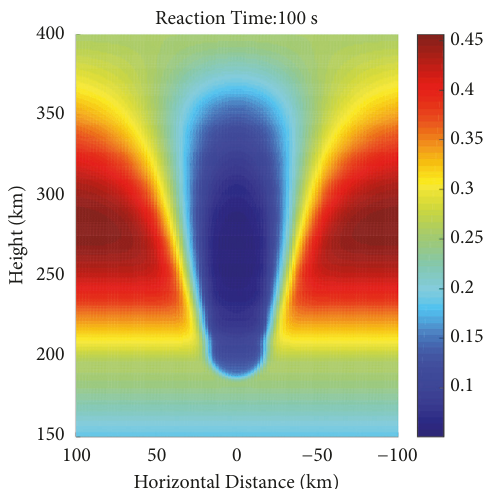
Figure 6: Electron density profile of H 2 O released from the ionosphere in the simulated exhaust plume in Nanjing in